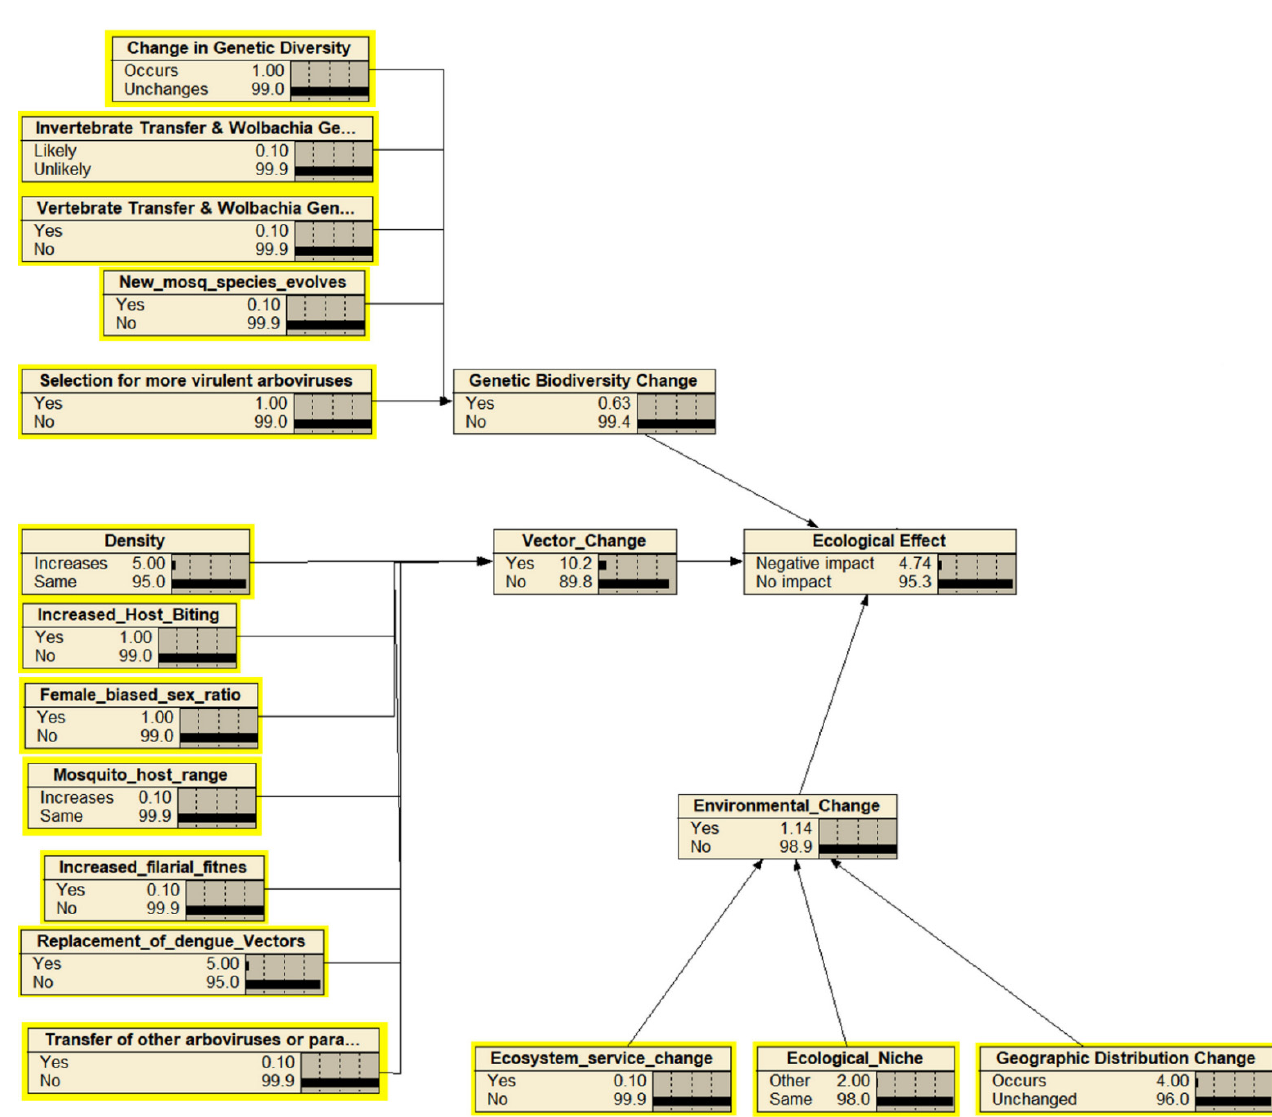
Figure 3. The Bayesian belief network for the endpoint “ecological effects”. Each node (box) repre- sents probability of hazards that might occur within the next 30 years as the result of the release of Wolbachia -infected Ae. aegypti . Parent nodes are in the yellow boxes.